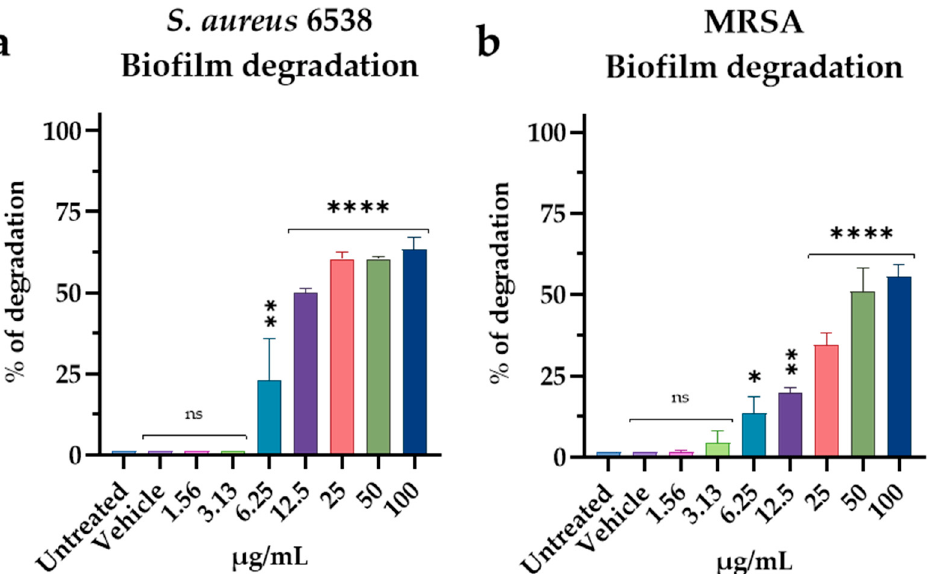
Figure 7. Degradation of mature biofilms produced by ( a ) S. aureus 6538 and ( b ) MRSA. Statistical analyses were determined by ANOVA with Dunnett’s test for multiple comparisons. Significances are referred to the untreated bacteria. **** p < 0.0001, ** p < 0.0021, * p < 0.0332, ns (not statistically significant).